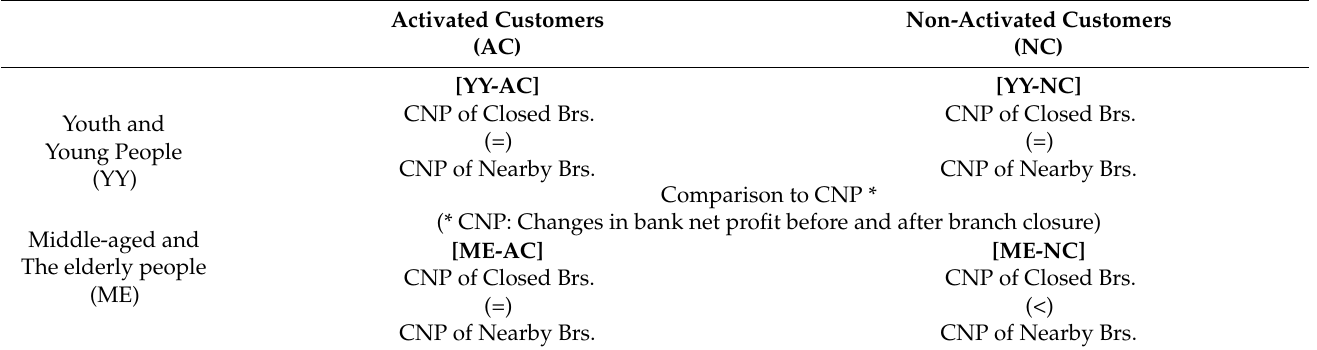
Table 12. Result of H1 testing through 2 by 2 hybrid